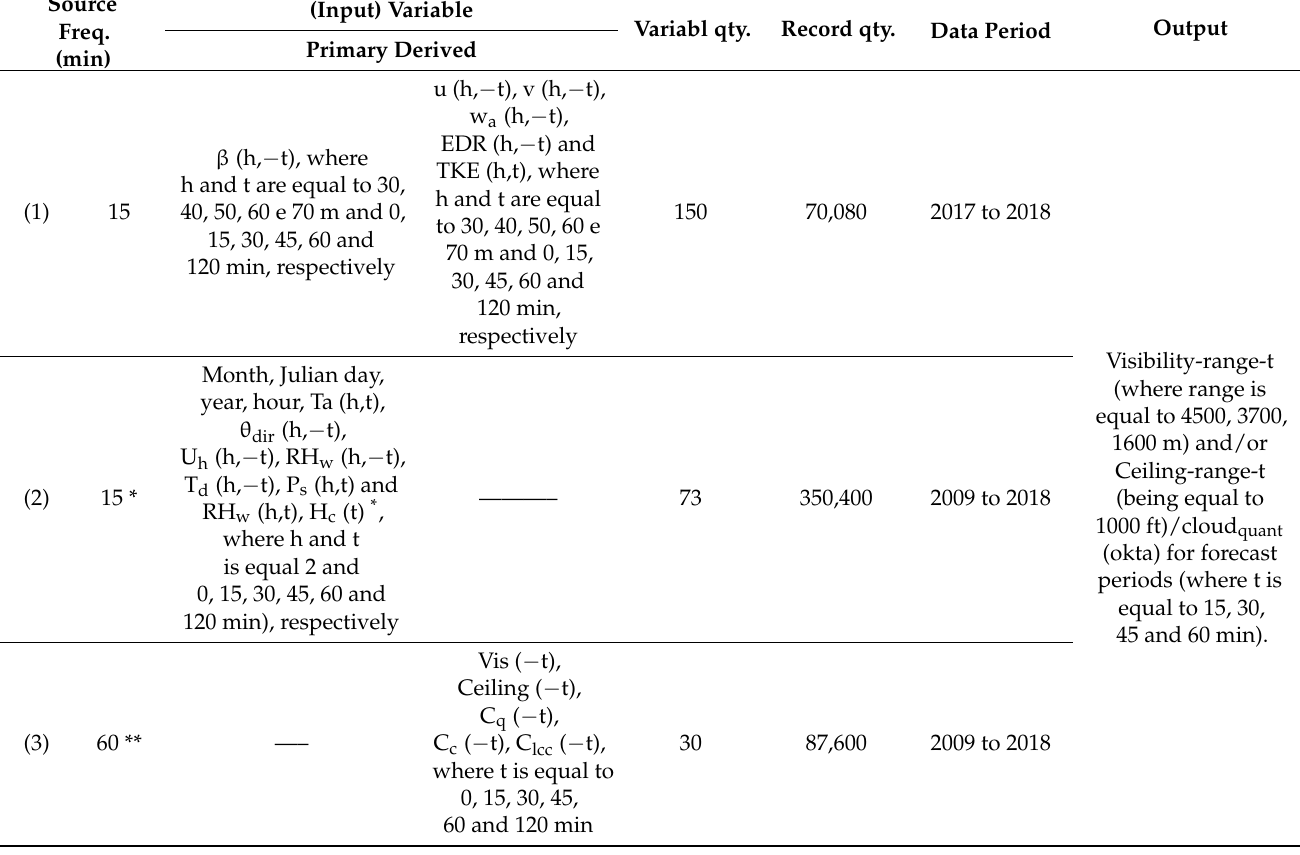
Table 2. Observation characteristics and meteorological variables used in the machine learning algorithms during training and testing. A total of 253 meteorological variables were used in the analysis. Source